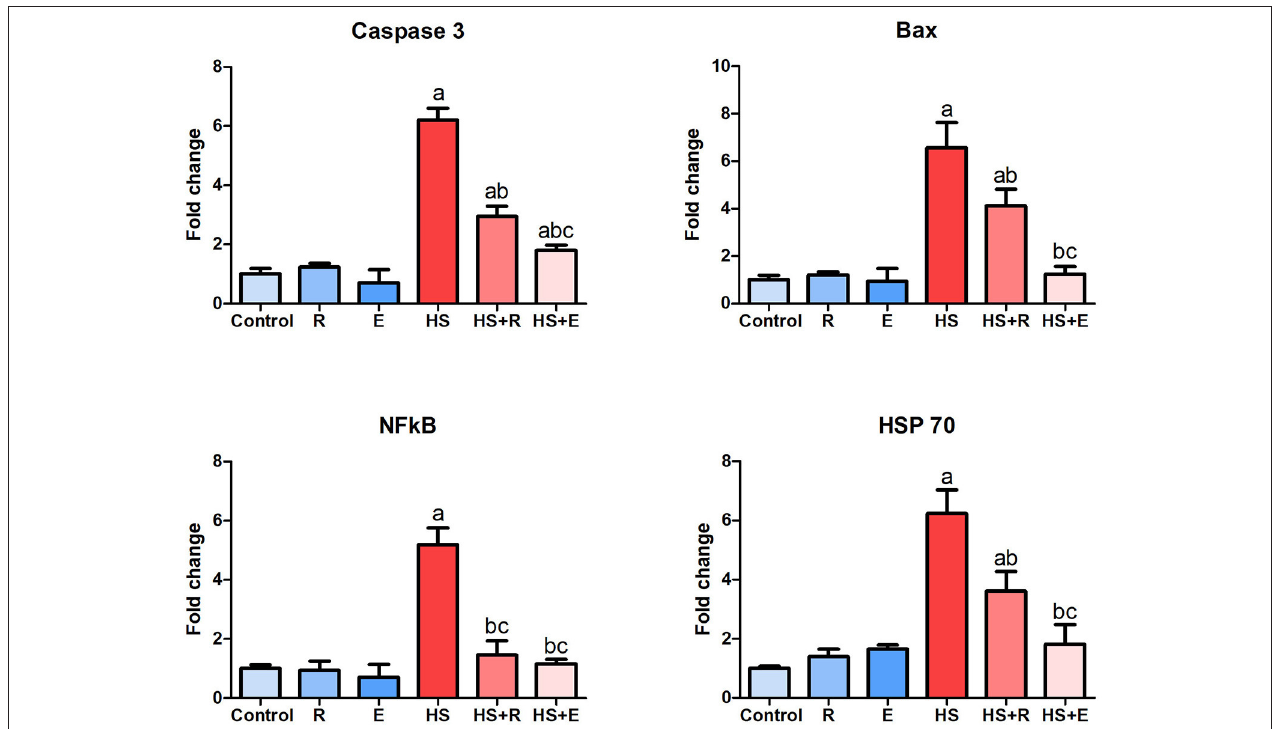
FIGURE 6 | Expression of caspase 8, Bax, NF- κβ 1, and HSP 70 genes within the bursa of Fabricius. Data are expressed as mean ± SD, and superscript letters a, b, and c indicate significance in comparison with the control group, HS group, and HS + R group,